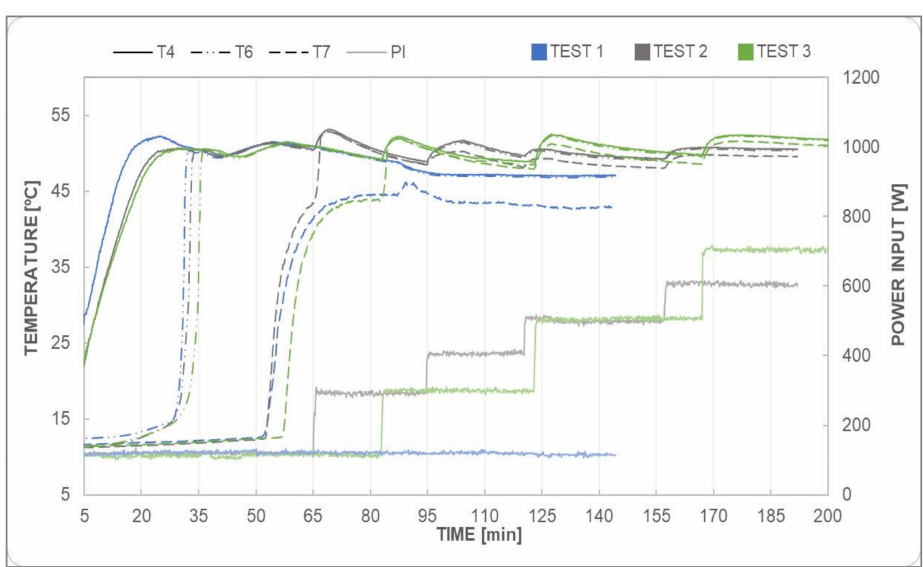
Figure 4. Stability test outcome for various power input increments.